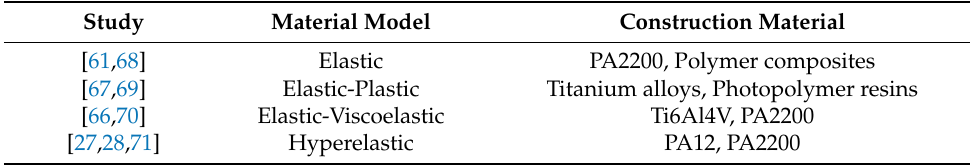
Table 2. Numerical studies with different applied material